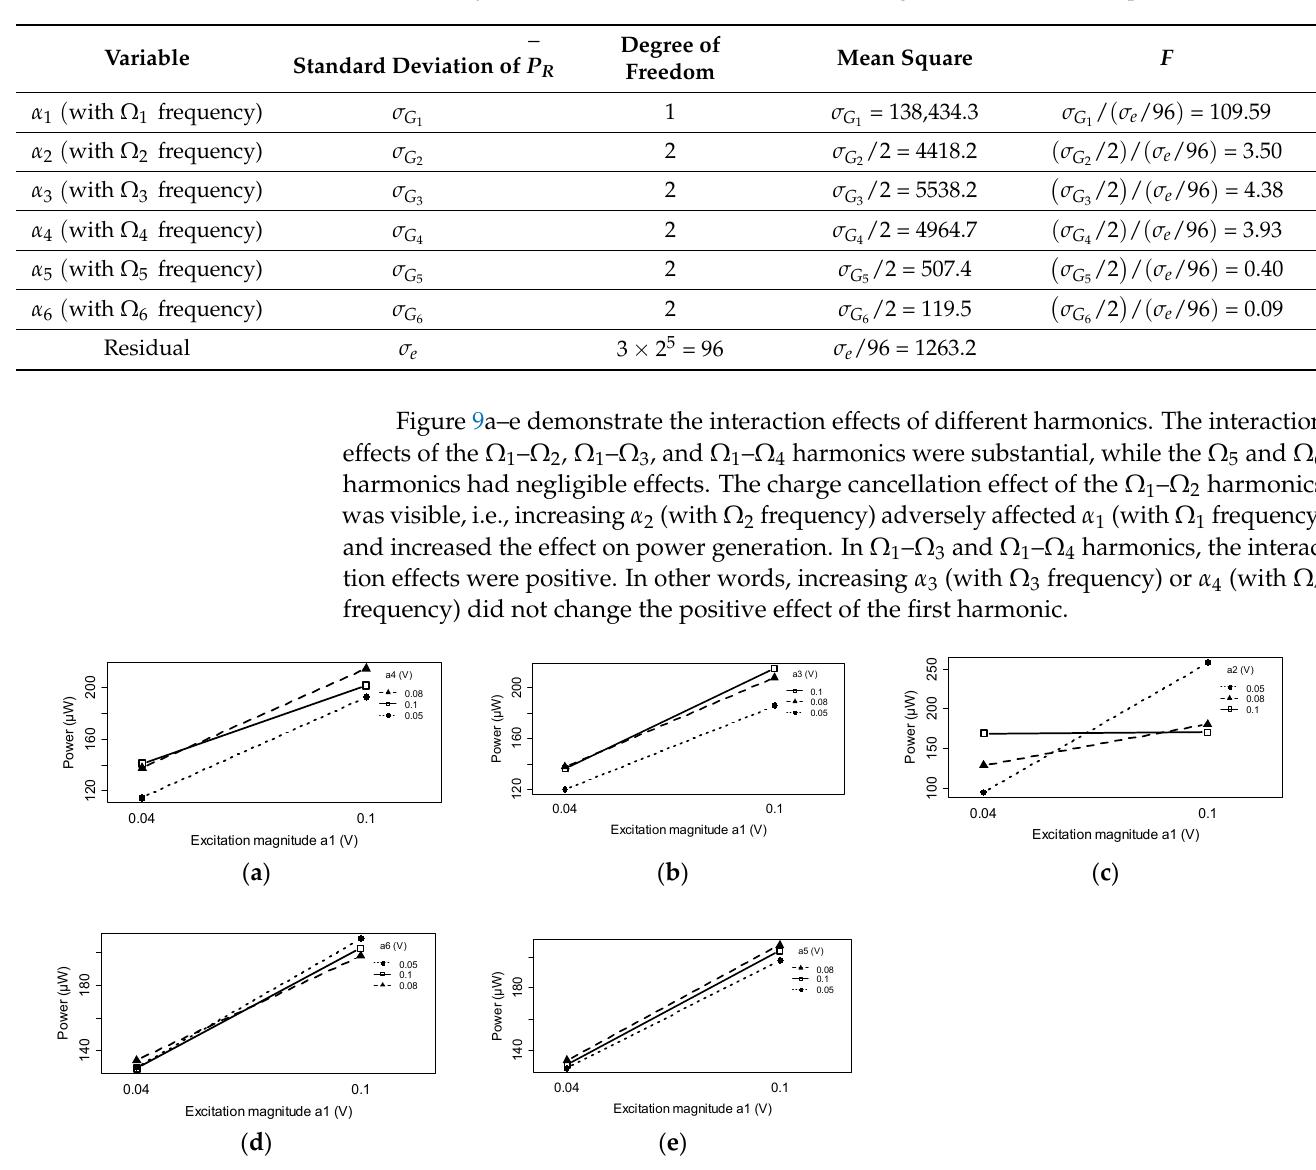
Table 5. Analysis of Variance (ANOVA) table of the designed test with three duplications.